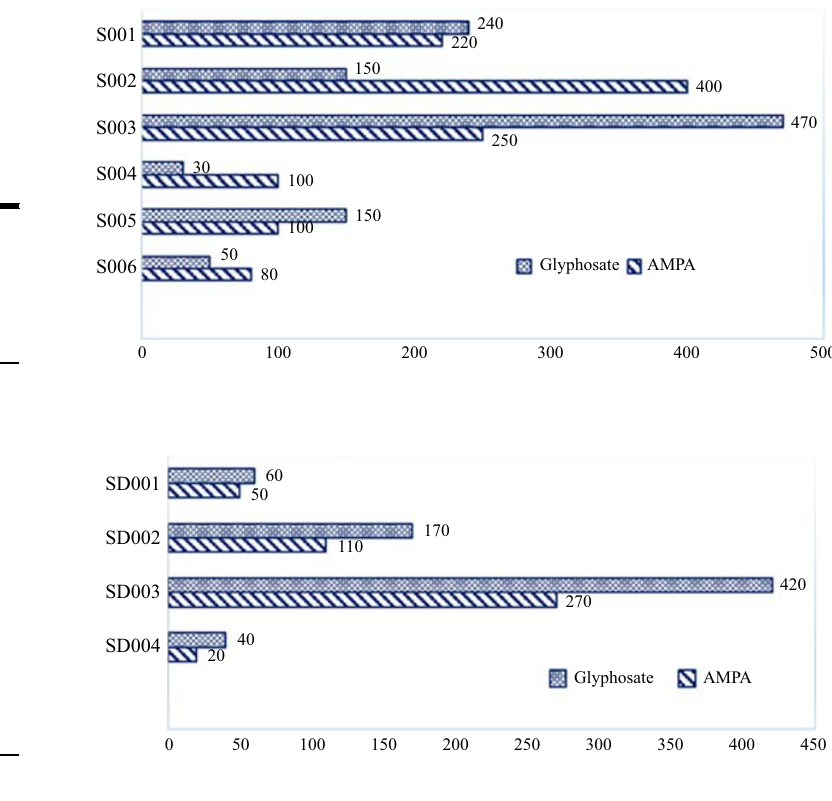
Figure 5. Residues of glyphosate and AMPA in the sediment samples ( µ g./kg.)